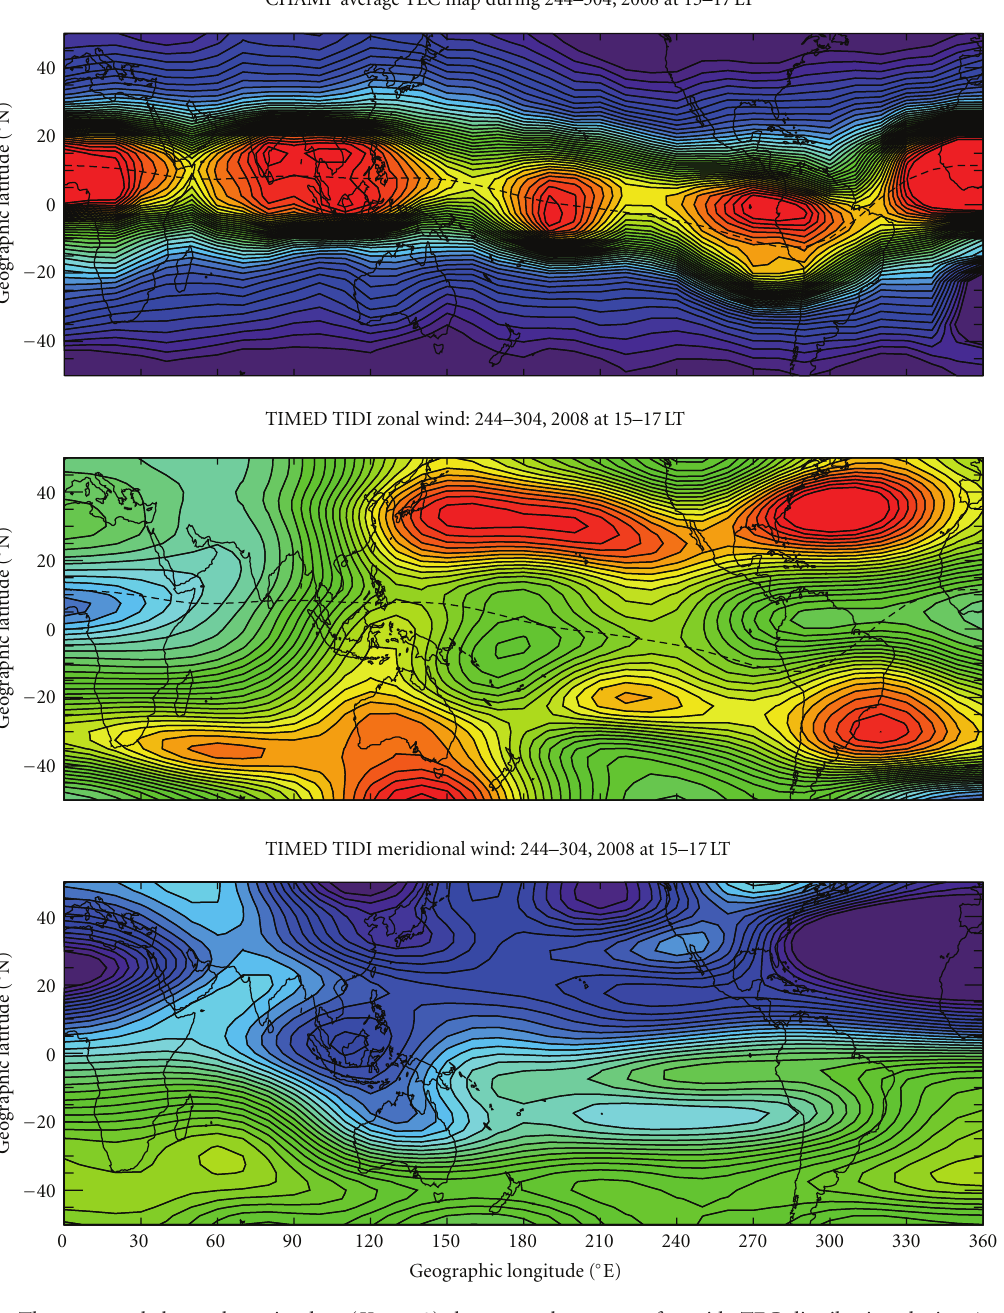
Figure 5: The top panel shows the quiet days ( K p ≤ 3) three-month average of topside TEC distribution during August–October 2008 for 1500–1700 local time sectors. The bottom two panels present the latitude/longitude maps of the zonal (middle panel) and meridional (bottom panel) wind components averaged for same time period as for topside GPS